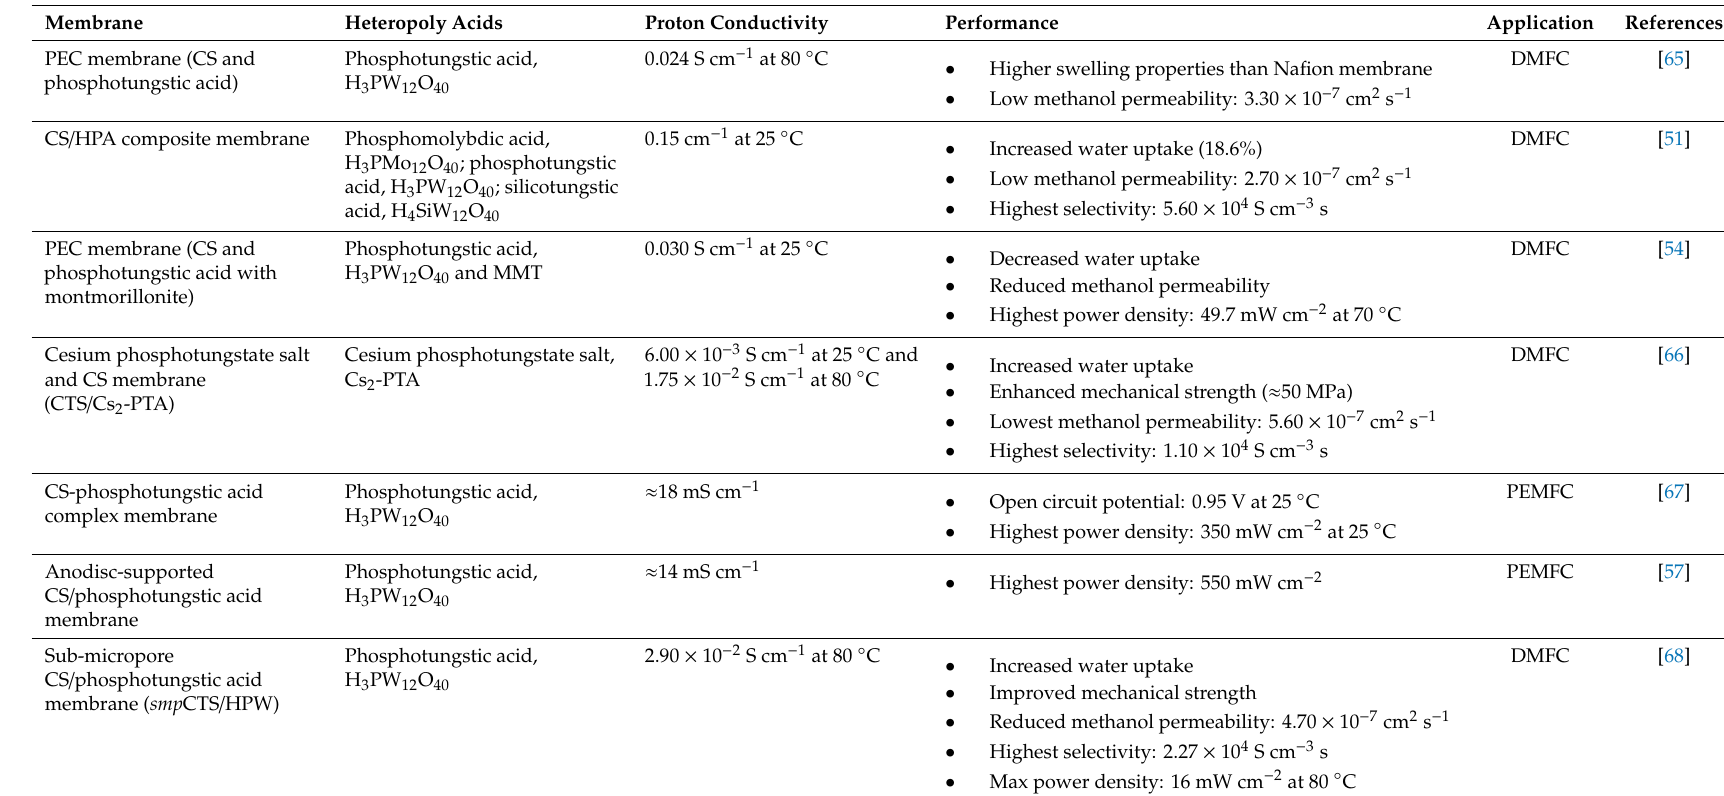
Table 2. HPA-related CS hybrid